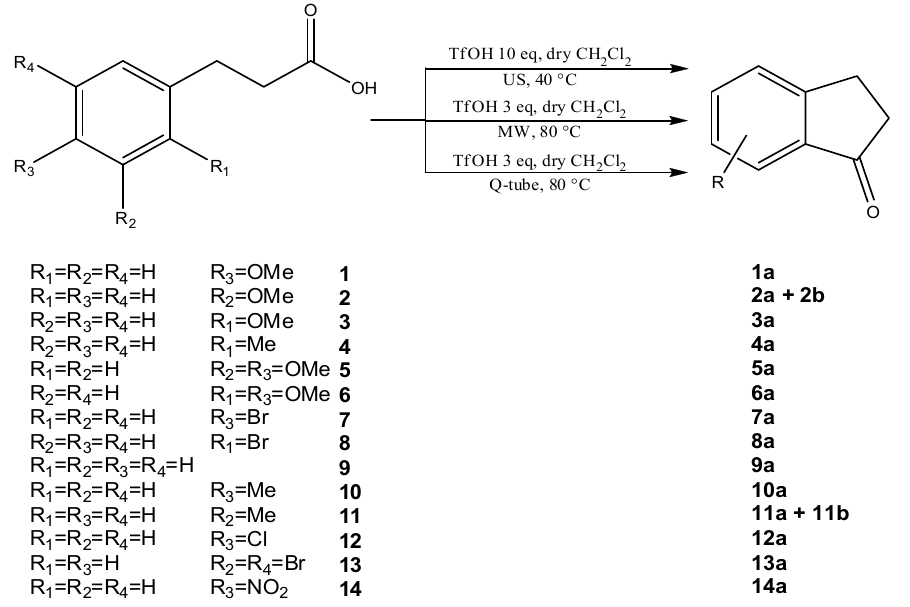
a Isolated yields; b The high temperature broke the Teflon septum; c Formation of intermolecular